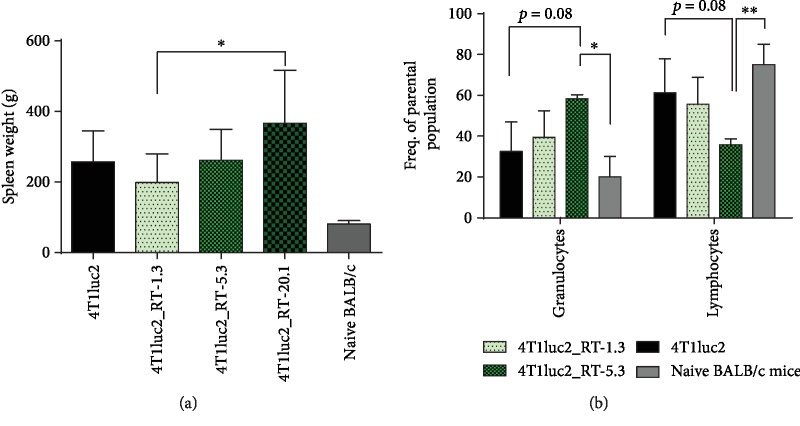
BALB/c mice ectopically implanted with 4Tluc2 and derivative clones expressing HIV-1 FSU_A reverse transcriptase (RT_A) have grossly enlarged spleens (a) and a disproportion in the leukocyte subpopulations in the spleen (b). Spleen weight, in mg (a) and proportion of leukocytes in the spleen (b) of BALB/C implanted with given 4T1luc2 derivative clones (n = 3-9) was assessed at the experimental end-point, and represent mean ± SD. Data from naïve BALB/c mice (n = 3-5) is given for comparison. ∗p < 0.05; ∗∗p < 0.005 (two-way ANOVA test).